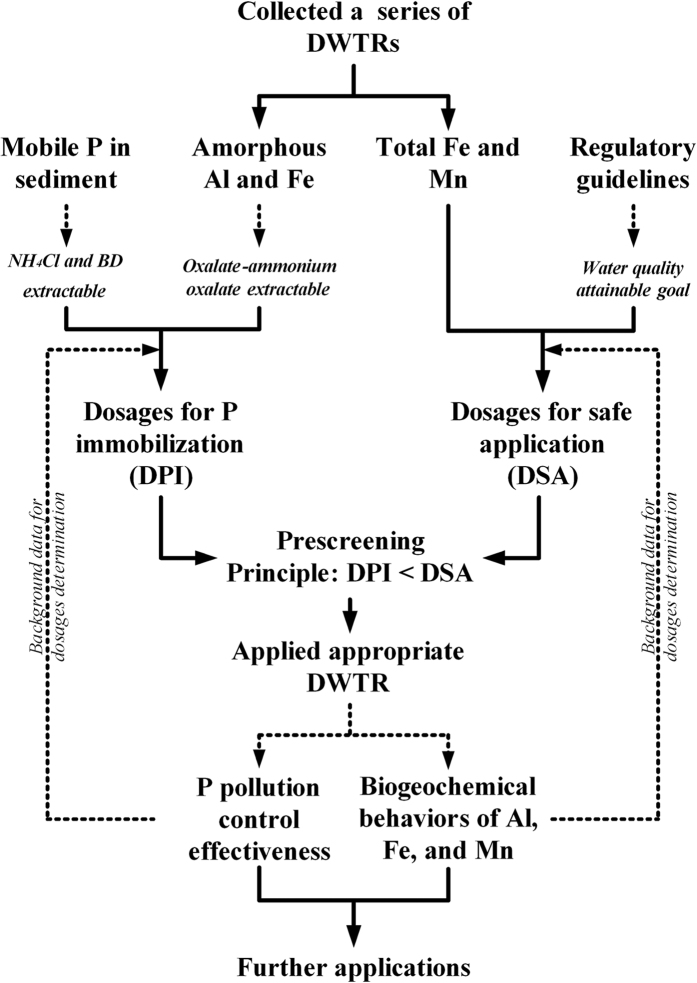
Recommended procedures for DWTR prescreening to control eutrophication.BD denotes Na2S2O4 and NaHCO3.